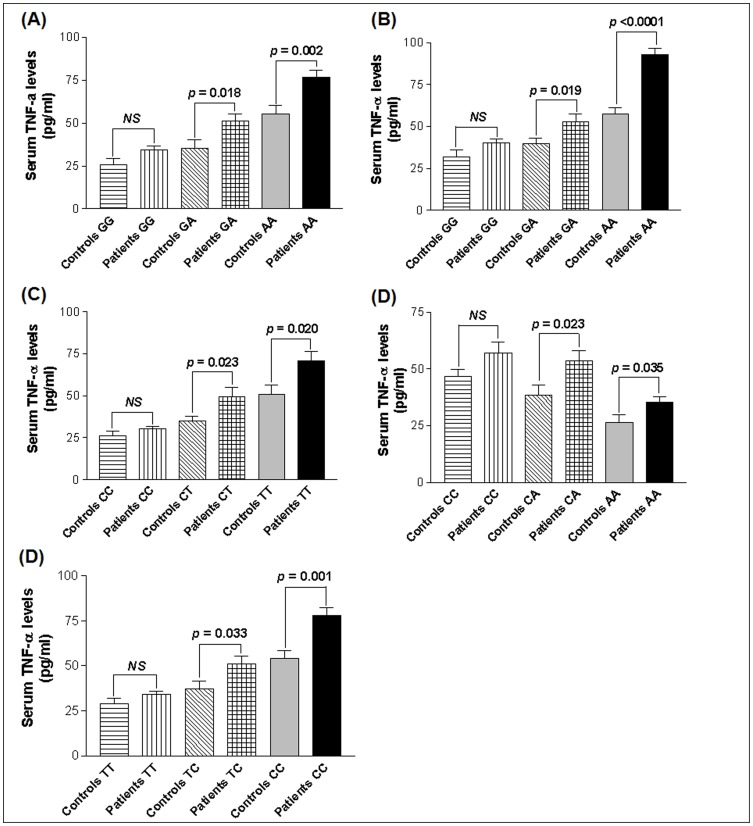
Serum TNF-α levels with respect to promoter genotypes in controls and vitiligo patients.(A) Comparison of sTNF-α levels (pg/ml) with respect to −238 G/A genotypes in 214 vitiligo patients and 236 controls, as determined by ELISA. (B) Comparison of sTNF-α levels (pg/ml) with respect to −308 G/A genotypes in 214 vitiligo patients and 236 controls, as determined by ELISA. (C) Comparison of sTNF-α levels (pg/ml) with respect to −857 C/T genotypes in 214 vitiligo patients and 236 controls, as determined by ELISA. (D) Comparison of sTNF-α levels (pg/ml) with respect to −863 C/A genotypes in 214 vitiligo patients and 236 controls, as determined by ELISA. (E) Comparison of sTNF-α levels (pg/ml) with respect to −1031 T/C genotypes in 214 vitiligo patients and 236 controls, as determined by ELISA.